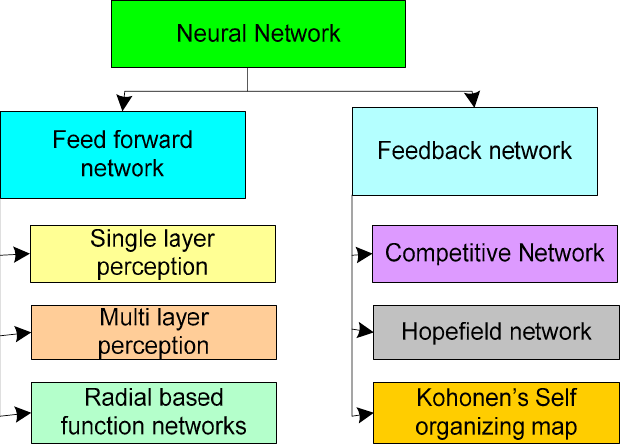
Figure 14. ANN Architecture.